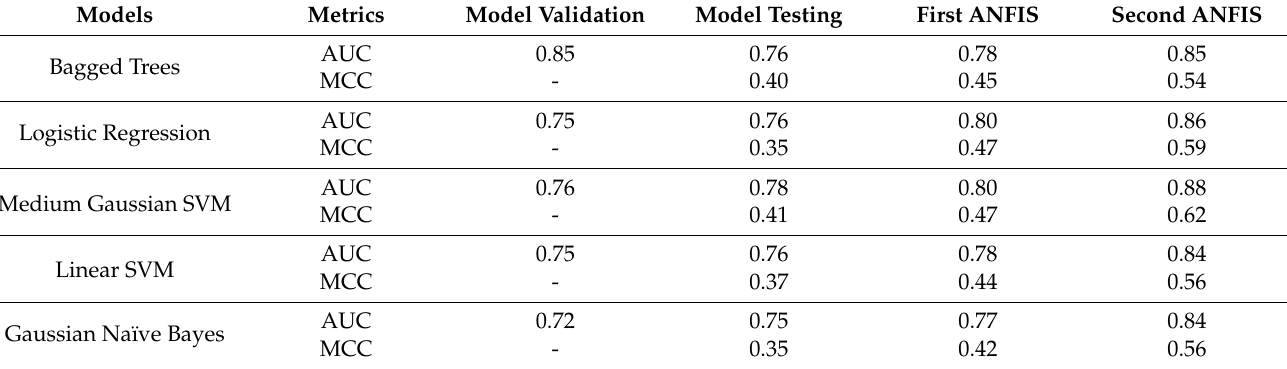
Table 10. Test results for AHI 15.